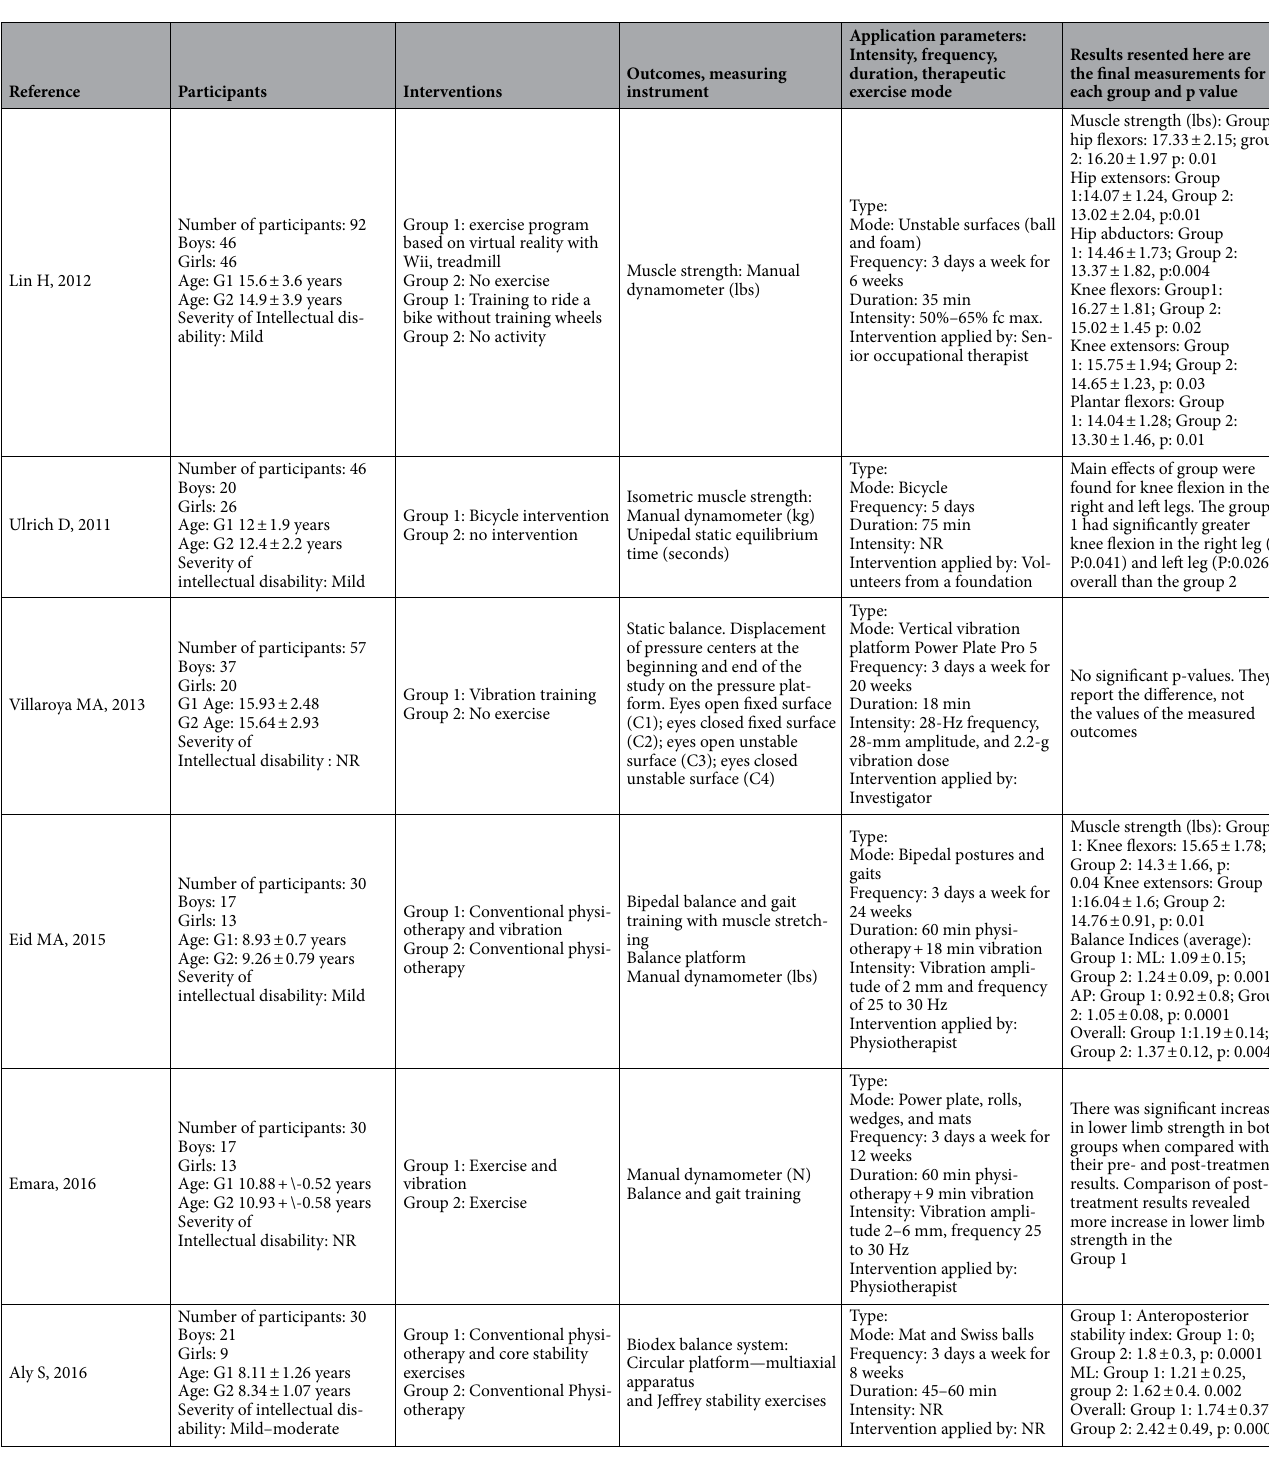
Table 1. Characteristics of the included studies. Group 1, Intervention; Group 2, Control group; MR, Maximum Resistance; pre, before-intervention values; post, after-intervention values; NR, no reported, ML, mediolateral, PRT, Progressive resistance